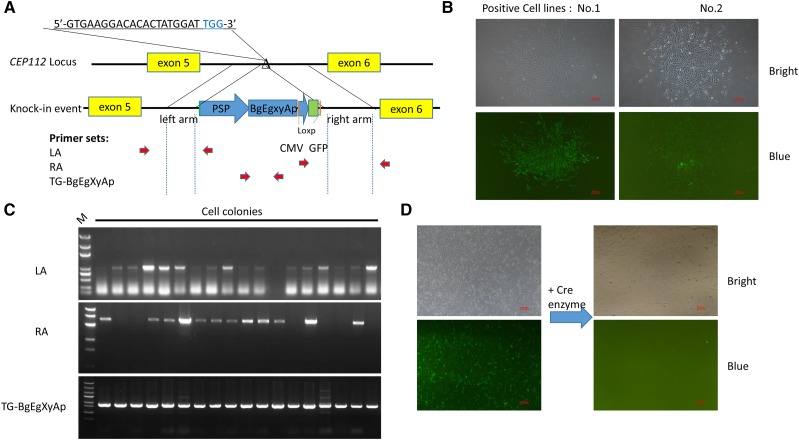
Effects of the length of HA on the screening of KI cell lines. (a) Schematic diagram of the strategy for the insertion of the BgEgXyAp and fluorescence-labeling genes into porcine CEP112 intron 5. Triangles indicate Cas9 targeting sites, blue letters are PAM sequences, pink dashes indicate loxp sequence, and red arrows are primer sets for PCR assay. (b) Fluorescent monoclonal cell screening. (c) Analysis of KI event by gel electrophoresis. (d) Fluorescent labeling gene was deleted by Cre enzyme before SCNT.